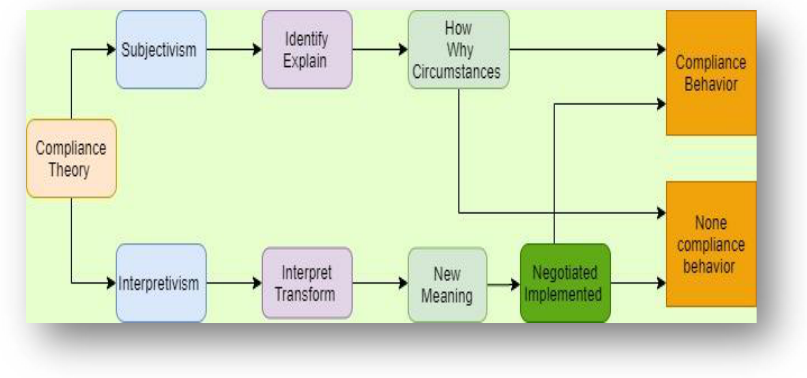
Figure 1: Compliance theory